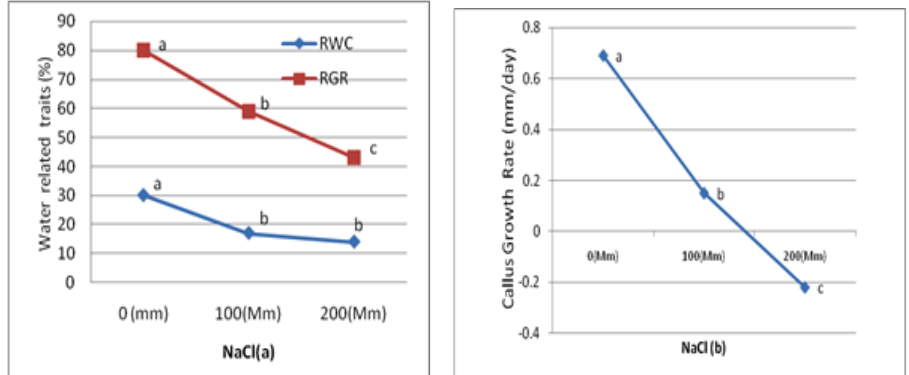
Fig. 1: Effect of in vitro NaCl stress on the callus RWC and RGR ( a ) callus growth rate ( b ) of Plantago ovata . Means by common letter do not significantly differ at the LSD